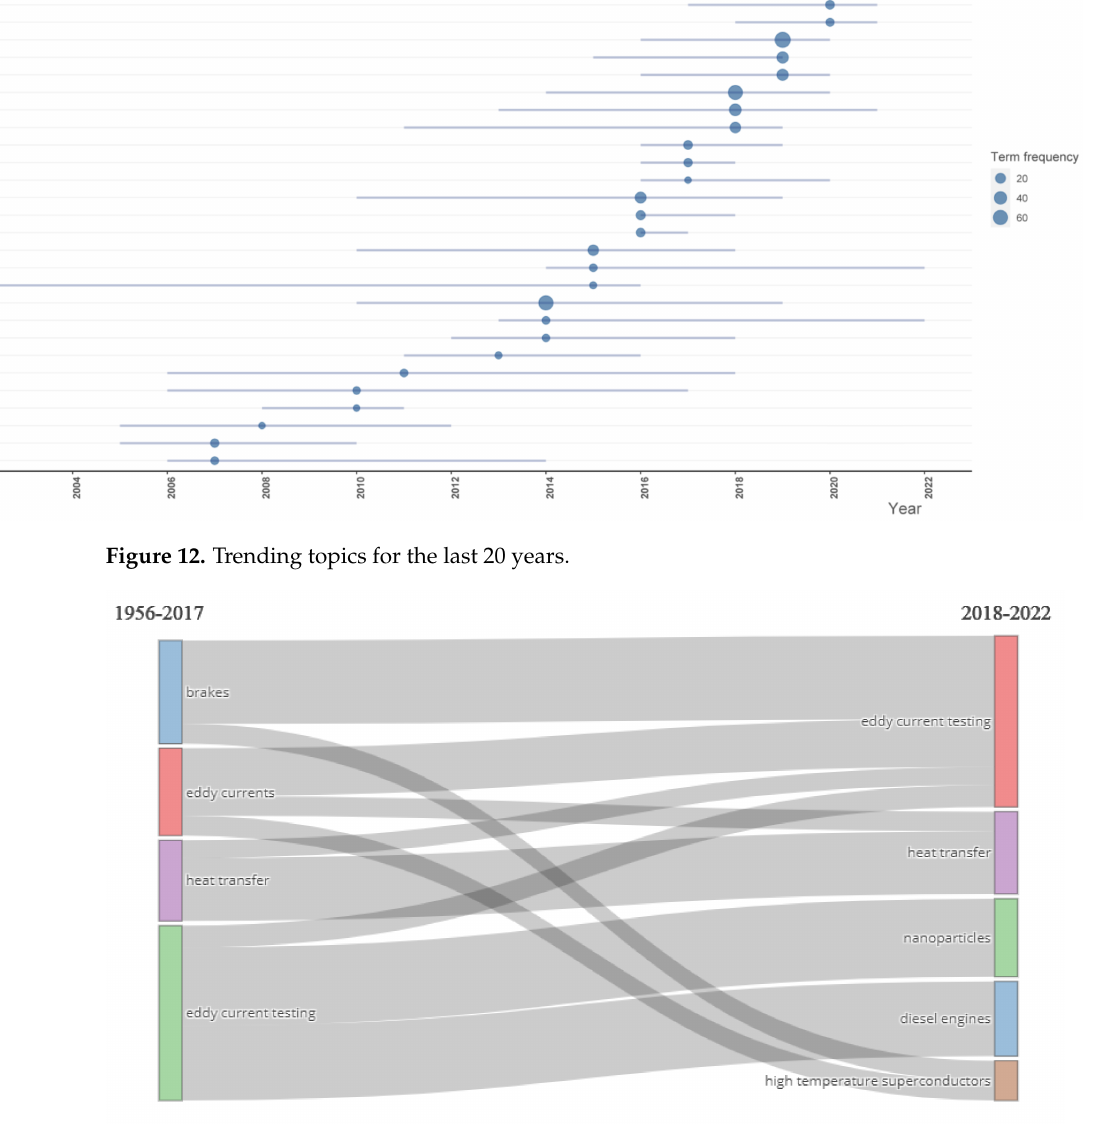
Figure 13. Thematic